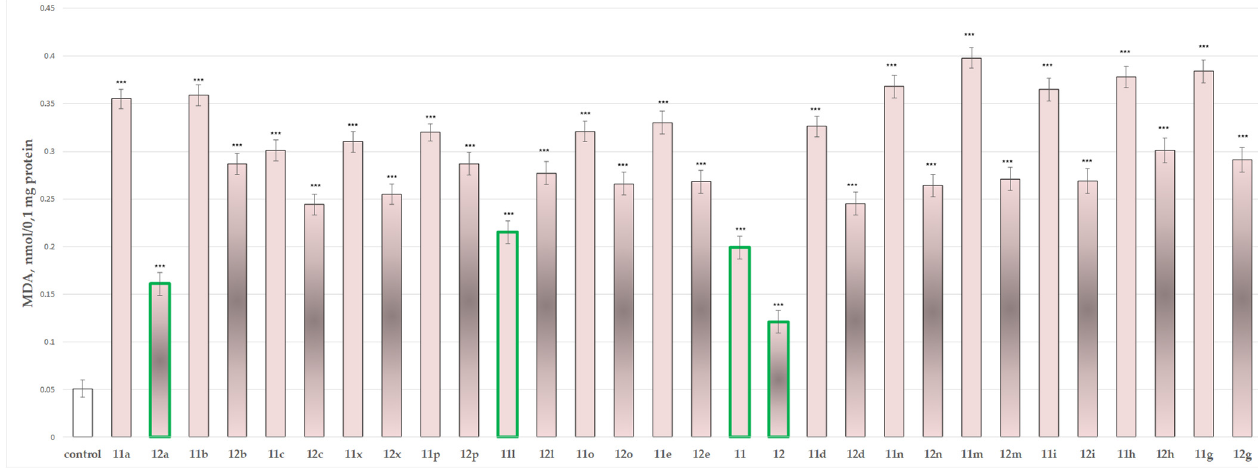
Figure 6. Effects of compounds 11 , 11a – 11x, 12 and 12a – 12x (100 μ mol), applied alone, on MDA production. *** p < 0.001 against the control (untreated mitochondria). The green outline indicates the most promising derivatives.